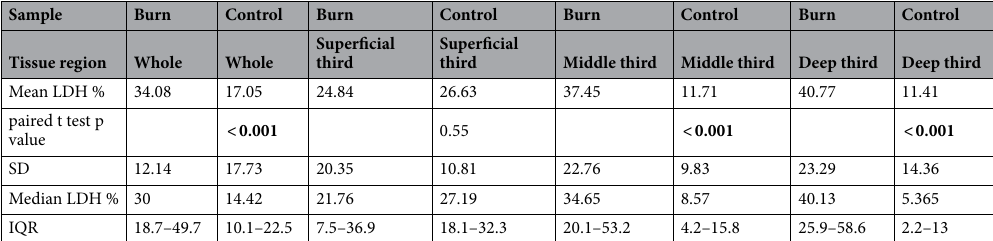
Table 3. Summary of regional LDH percentage analysis. N = 36. Each p value calculated using paired-t test with each burn sample paired with the control sample from the same patient. LDH lactate dehydrogenase